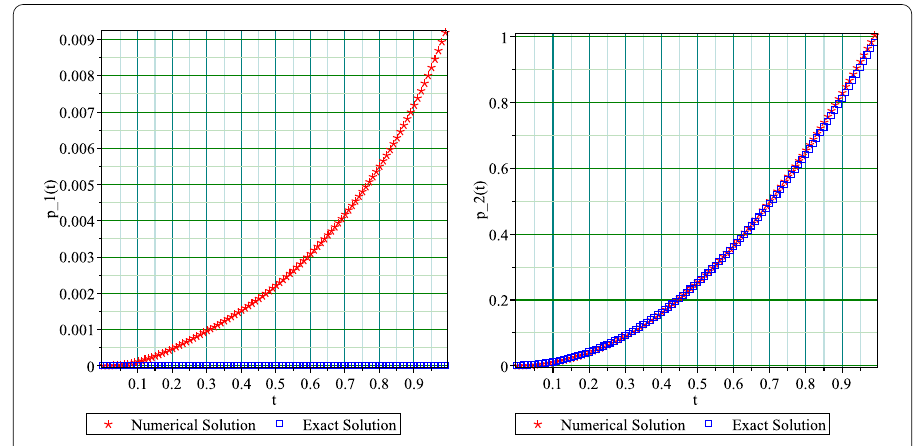
Figure 1 The plots of approximation and exact solutions of p 1 ( t ) and p 2 ( t ) for Example 5.1 with the noisy data